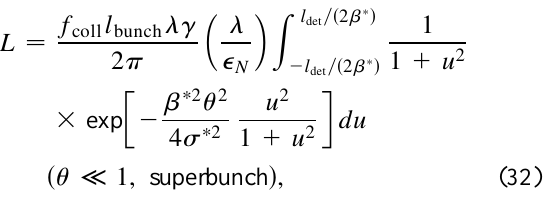
FIG. 2. (Color) Relative increase in LHC luminosity as a func- tion of the relative increase of the product of rms bunch length and crossing angle, (cid:2) s z u (cid:3) , starting from a nominal bunch length s z (cid:1) 7.7 cm and crossing angle u (cid:1) 300 m rad [11], and main- taining a constant total beam-beam tune shift for two colli- sions with alternating crossing. The transverse rms beam size is s (cid:1) (cid:1) 16 m m and the interaction-point beta function b (cid:1) (cid:1) 0.5 m. The subindex “0” refers to the nominal initial parame- ters listed above.